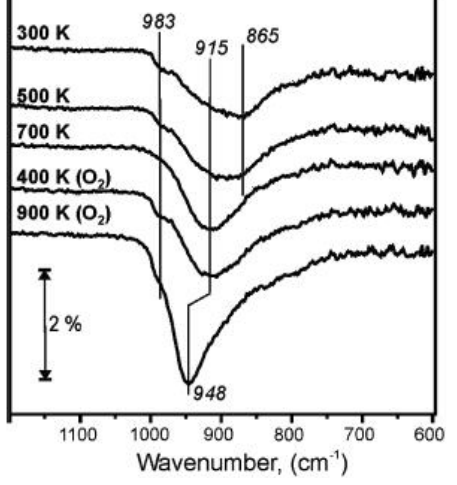
Fig. 15 – IRA-spectra of 2.5Å niobia sample annealed to the indicated temperature and subsequently oxidized in 10 –7 mbar of O 2 at 400 K and then at 900 K. The Nb=O band at 983 cm –1 disappeared at 700 K and is recovered upon oxidation treatment. All measurements were performed at room temperature. The spectra are offset for clarity (Uhl et al.